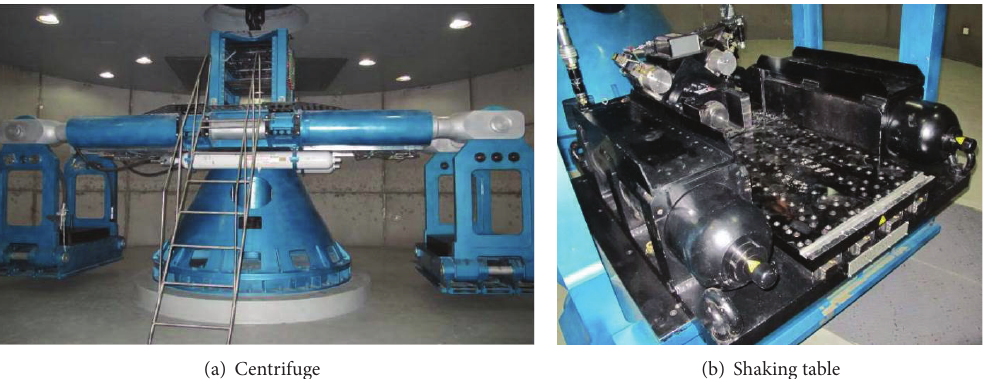
Figure 1: Centrifuge and shaking table.